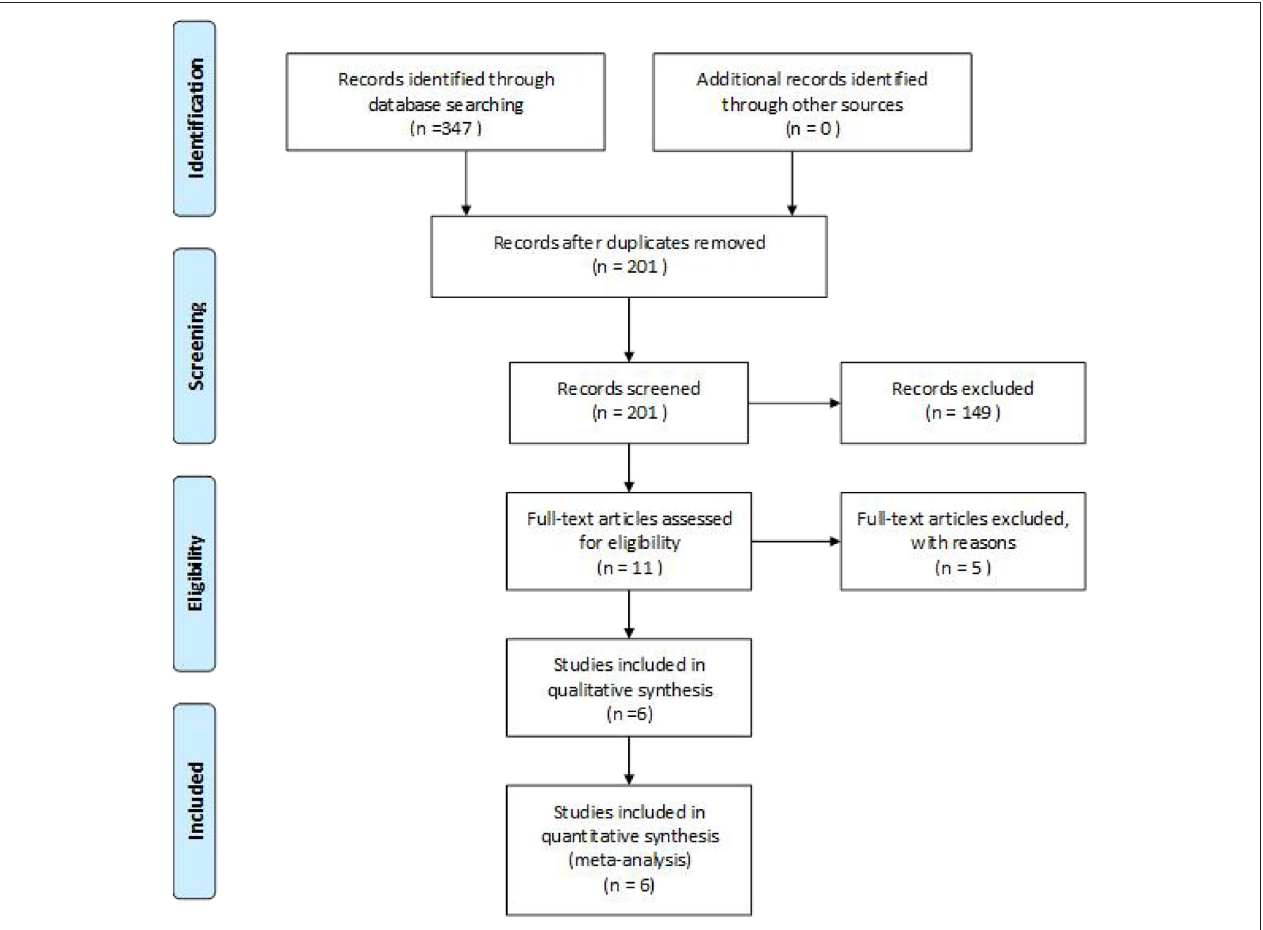
FIGURE 1 | The search results and selection